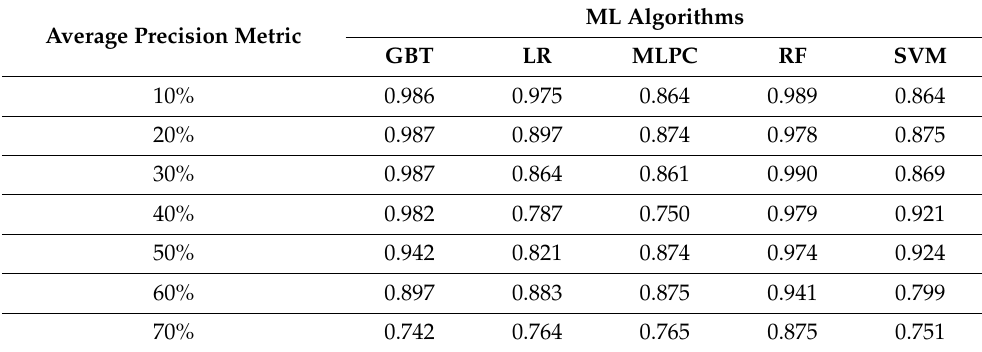
Table 5. Model Precision Results of the network and comparison with other networks.